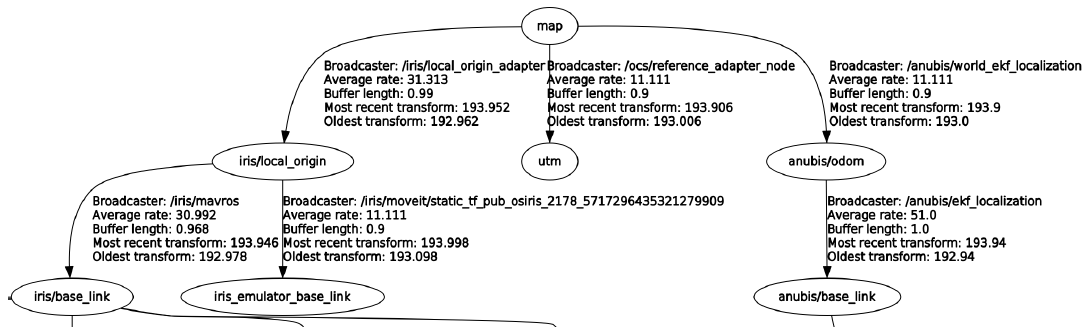
Figure 6. Excerpt of TF tree of the system in simulation. Both vehicles have a base l ink frame. Since they are prepended by the vehicle names “iris” and “anubis”, the frames are